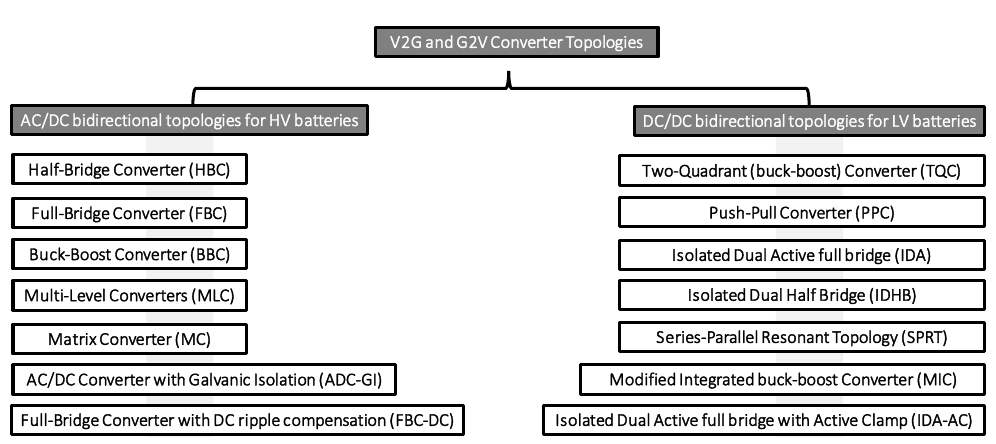
Figure 7. AC/DC and DC/DC topologies for HV and LV battery systems. Table 4. Comparison of AC/DC Converters for HV Battery connection.